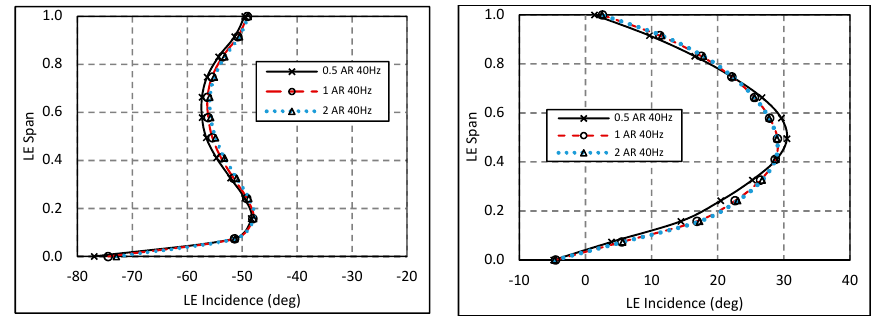
Figure 22. LE incidence at 40 Hz frequency. ( Left ) Minimum incidence running point; ( Right ) Maximum incidence running point.